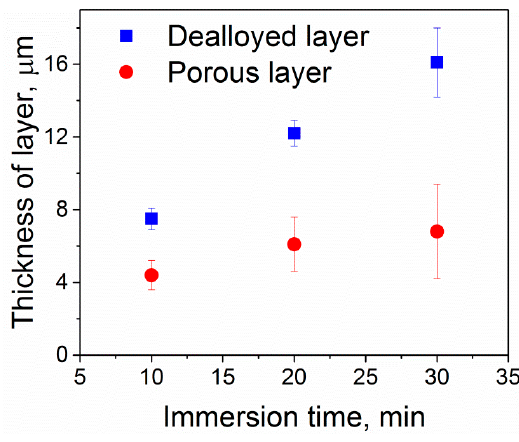
Figure 5. Surface characteristics of Ti-6Al-7Nb after dealloying. The thickness of the dealloyed (both porous and non-porous dealloyed layers, please see Figure 3) and the porous layers is plotted against the dealloying time. The error bars indicate standard deviation.